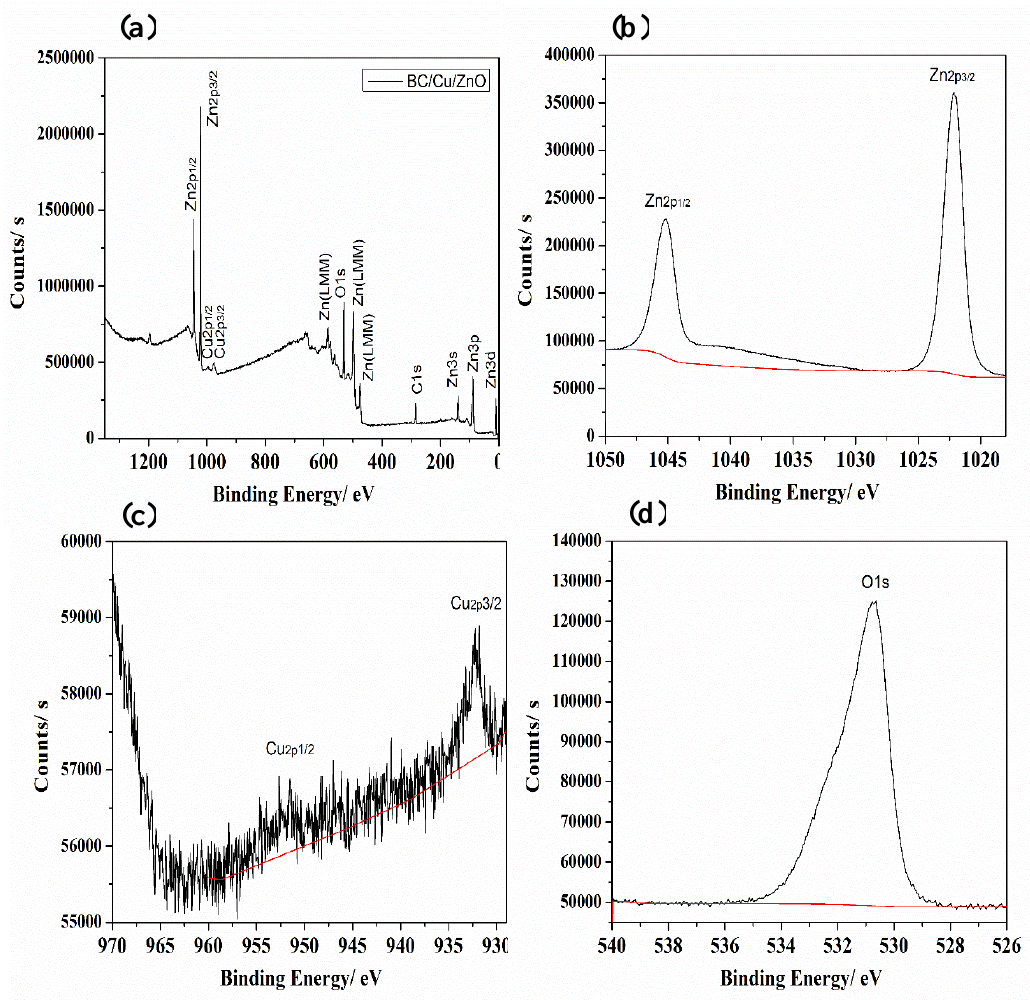
Figure 4. XPS peak representations of bacterial cellulose / copper / zinc oxide nanocomposite: ( a ) XPS full spectrum; ( b ) zinc peaks; ( c ) copper peaks; ( d ) oxygen peak.